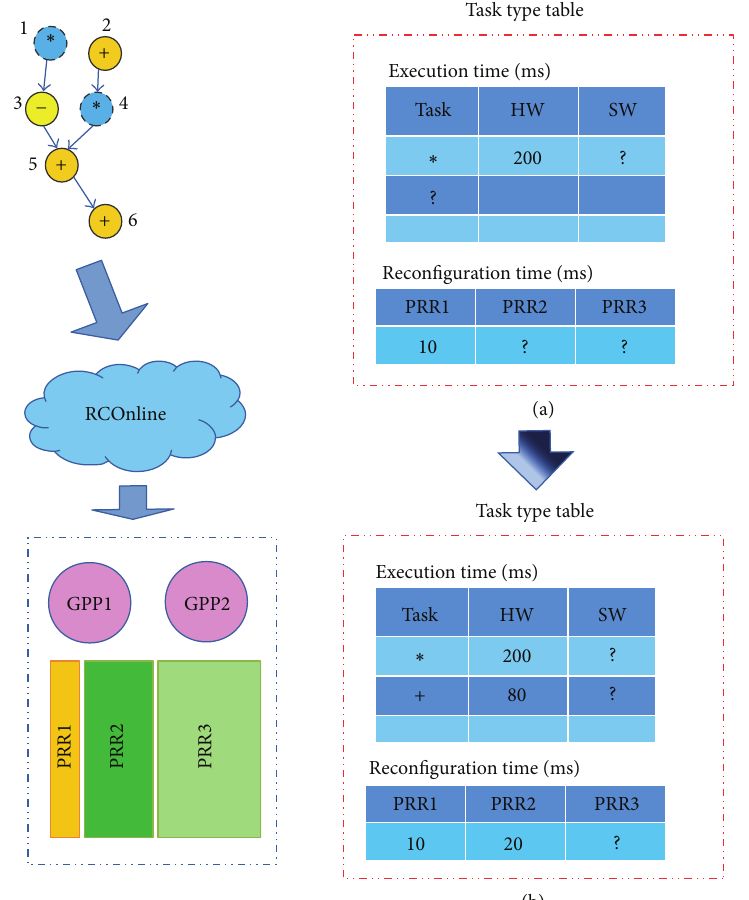
Figure 6: Learning in RCOnline